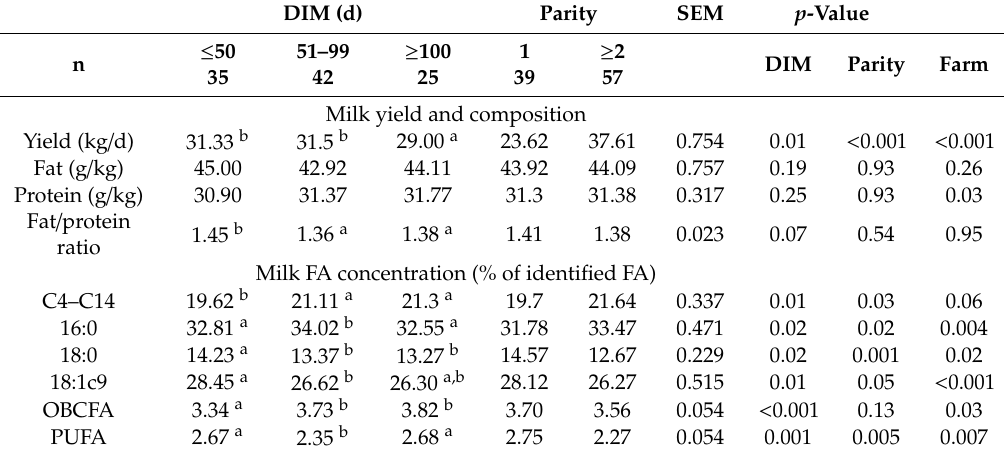
Table 2. Influence of days in milk, parity and farm on milk yield and composition and fatty acid concentrations in early lactation Holstein cows. DIM (d) Parity SEM p